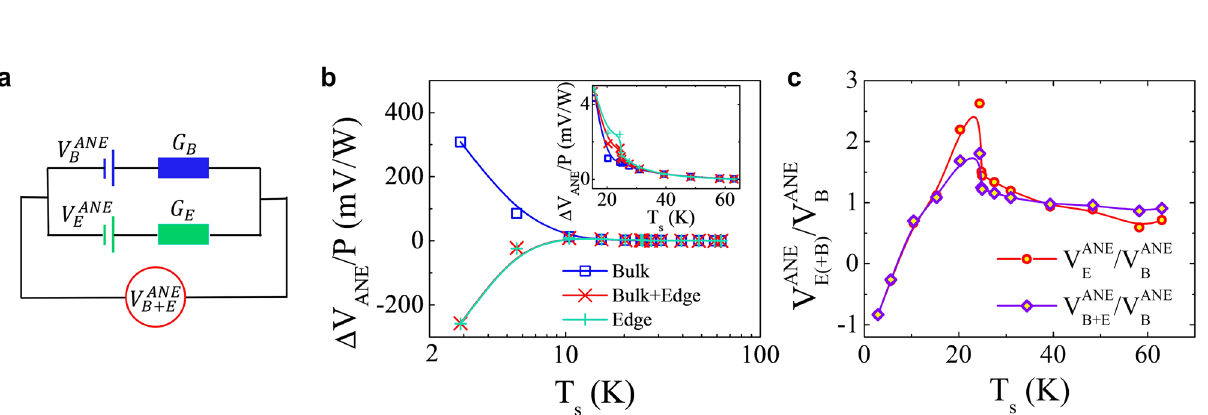
resistance from 5 – 6 (Bulk) and 13-14 (Bulk+ Edge). d , e ANE signals from 13 – 14 ( d ) and 5 – 6 ( e ) at selected temperatures. For T s < 20K, 40 loops are used for averaging; for T s > 20K, 20 loops are used for averaging. f , g 2 f current response f rom Bulk+ Edge (11 – 14 and 11 – 12) and Bulk-only (5 – 6 and 5-4) channels to AC voltage applied between the two outermost horizontal elec- trodes on ML-WTe 2 vs. H z at T s = 4 K ( f ) and 14K ( g ). 60 loops are used for averaging in f , and 10 loops for other curves than the 11 – 14 electrodes (3 loops) in g , respectively. The rms magnitudes of the AC voltage for 4K and 14K measurements are 20 and 200mV, respectively.